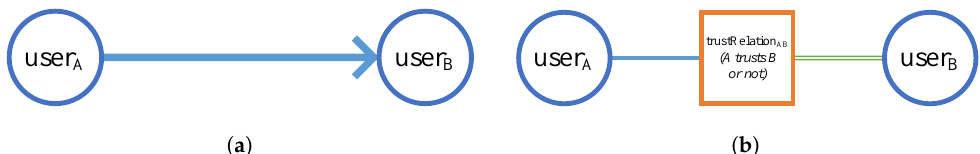
Figure 2. Demonstration of one user trusting another in the real world and in the proposed model. ( a ) Real-world trust relationship representation: user A trusts user B . ( b ) user A trusting user B rendered in the proposed model.